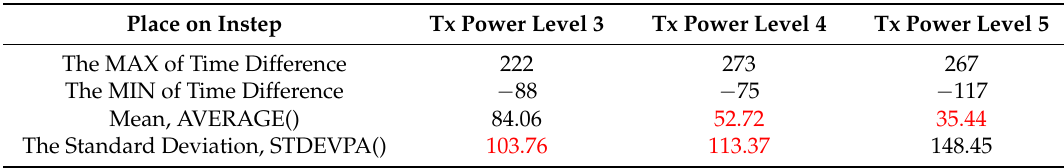
Table 10. Comparison of different Tx power levels with the BLE Tag on the instep. STDEVPA(), calculate function of standard